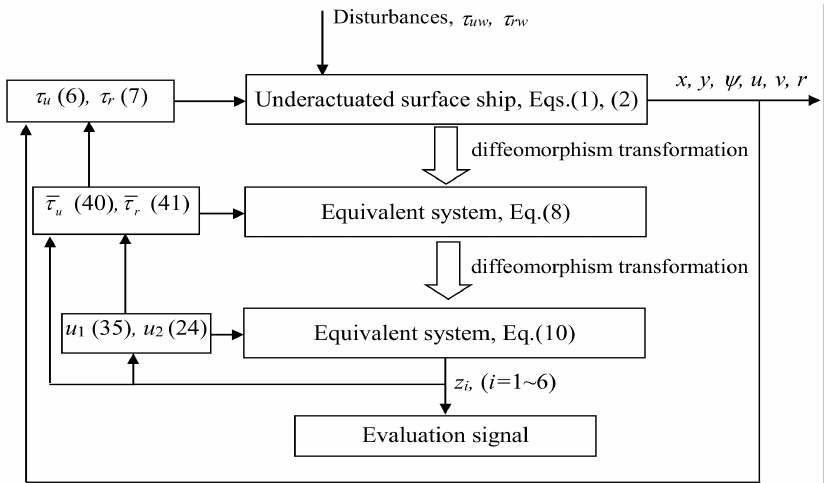
Figure 2. Framework of control system for the underactuated surface ship with disturbances.